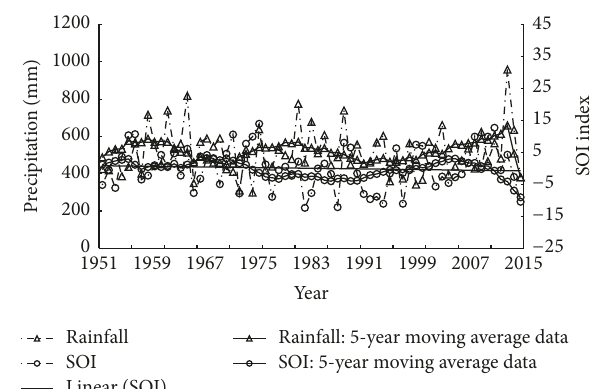
Figure 7: Variation in precipitation at Yan’an station and the SOI index from 1951 to 2015. Note . When the SOI was negative, El Nino occurred in the corresponding